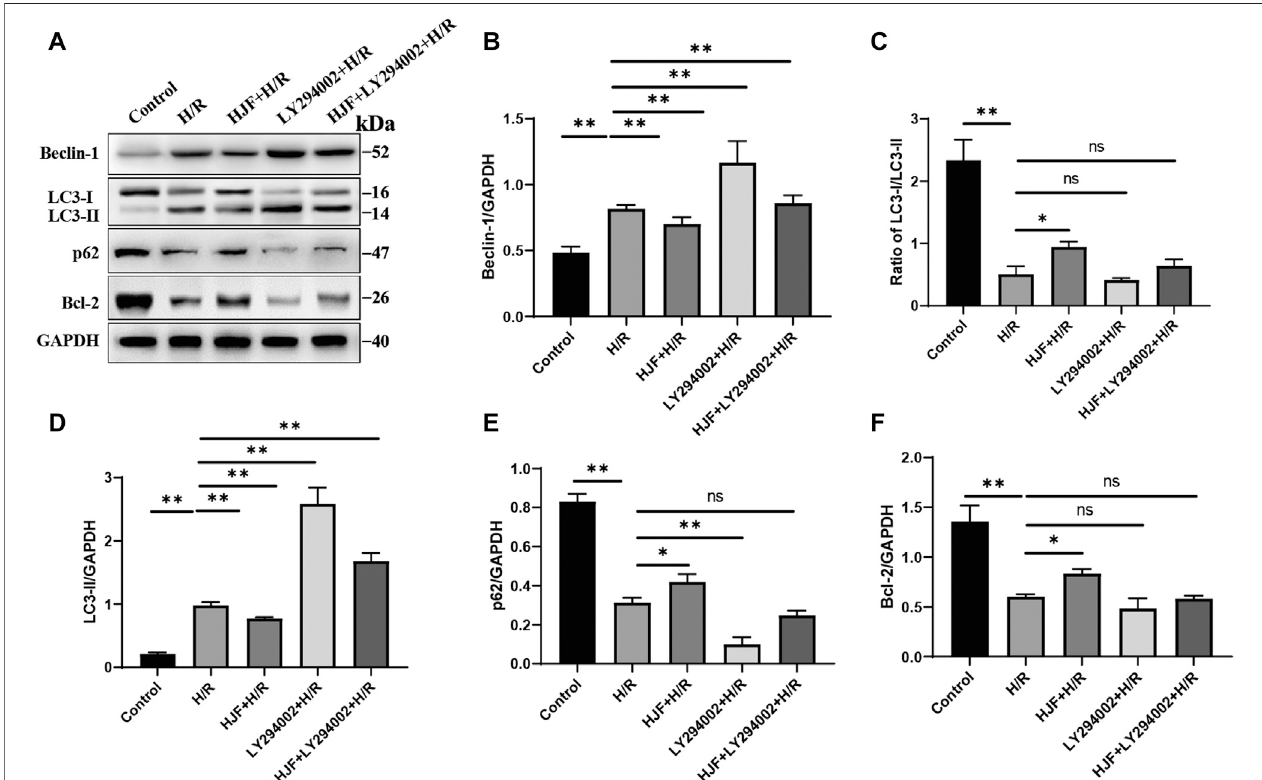
FIGURE 4 | Effects of HJF on autophagy-related proteins in H9C2 cells exposed to H/R. (A) , Representative western blot images of autophagy-related proteins; (B) ,Quanti fi cationofthelevelsofBeclin-1; (C) ,Quanti fi cationofthelevelsofLC3-II; (D) ,RatioofLC3-I/LC3-II. (E) ,Quanti fi cationofthelevelsofp62; (F) ,Quanti fi cationof the levels of Bcl-2. The data are shown as the means ± SDs in each group (n (cid:1) 3). * p < 0.05, ** p < 0.01. H/R, Hypoxia/reoxygenation; HJF, Huoxue Jiedu Formula.